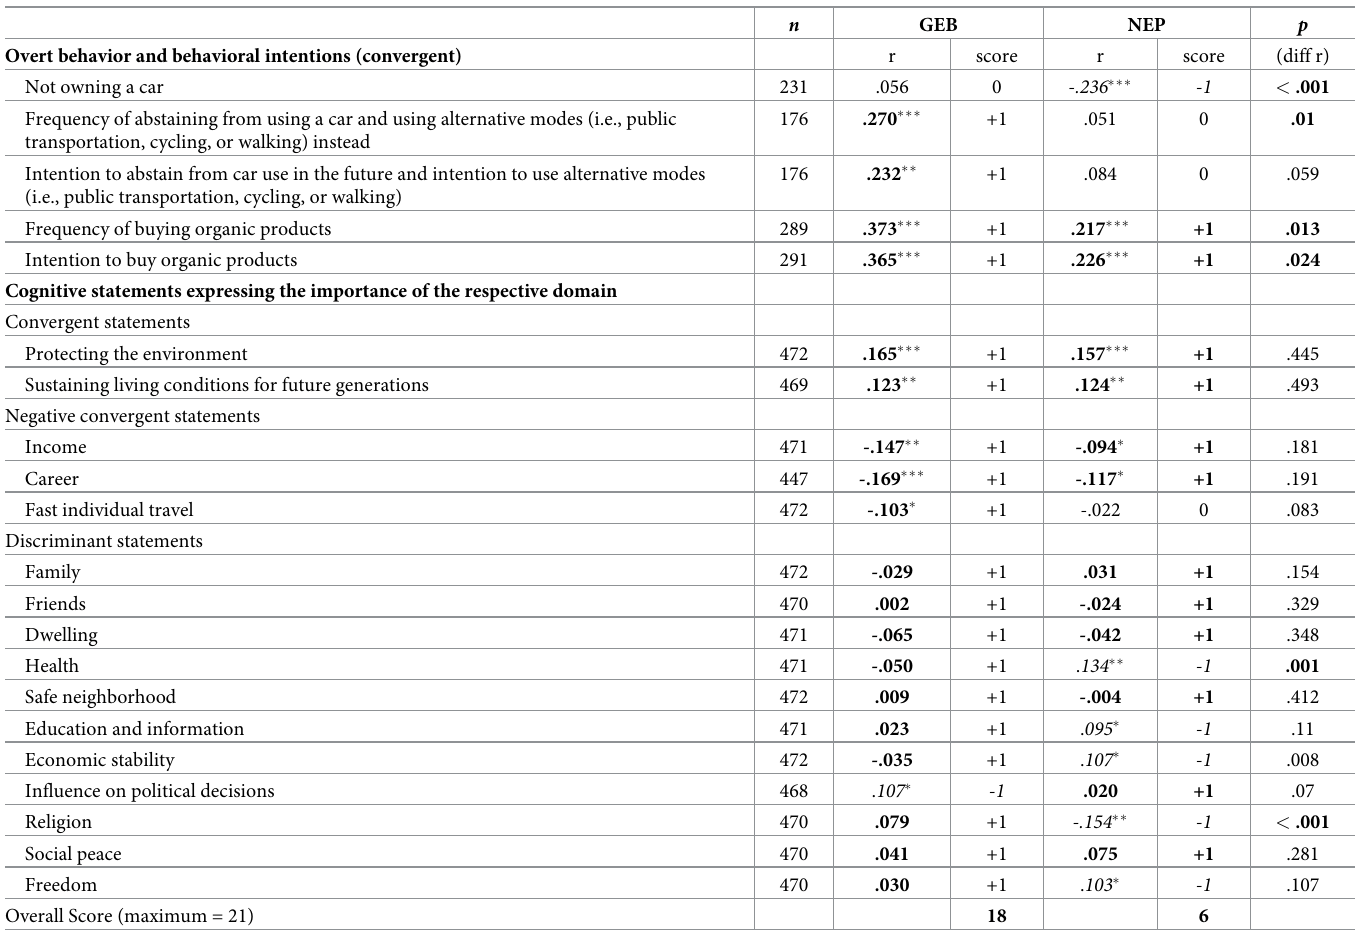
Table 1. Correlations of the NEP and GEB with the validation